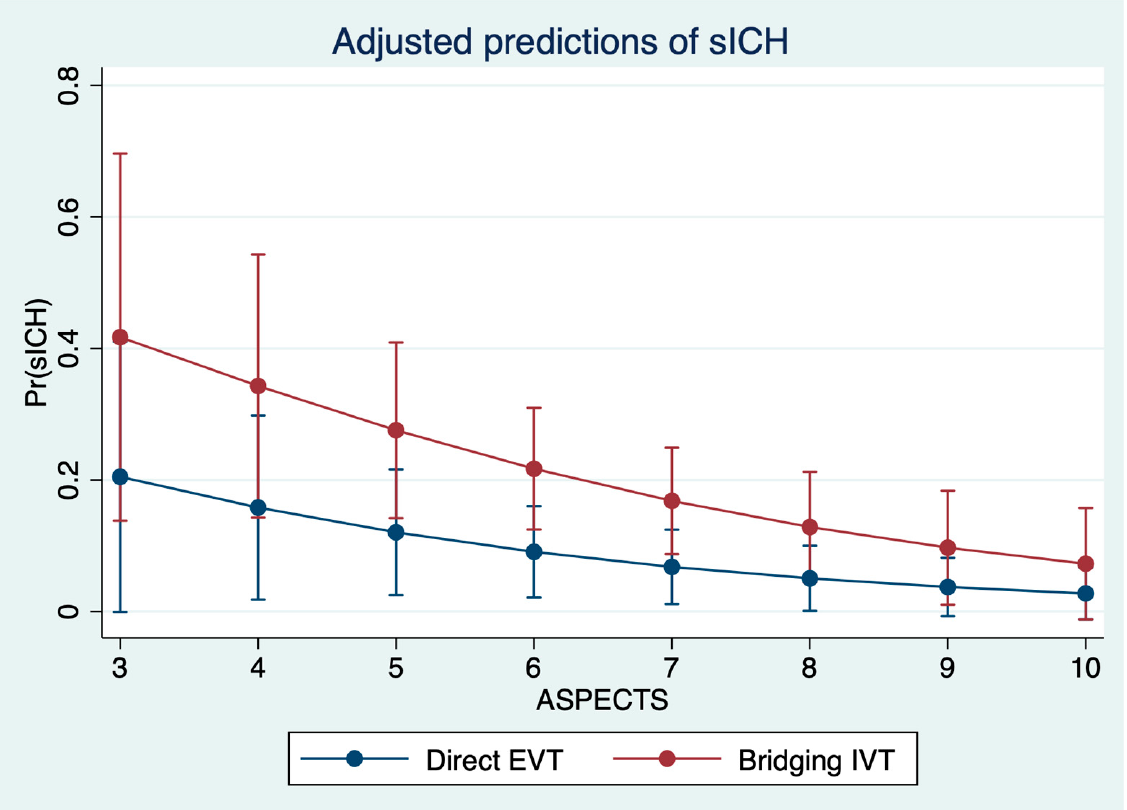
Figure 4. Prediction of symptomatic intracranial hemorrhage (y axis) based on multivariable logistic regression analysis to show the impact of IVT application according to the baseline ASPECTS, adjusted for time from onset to imaging.